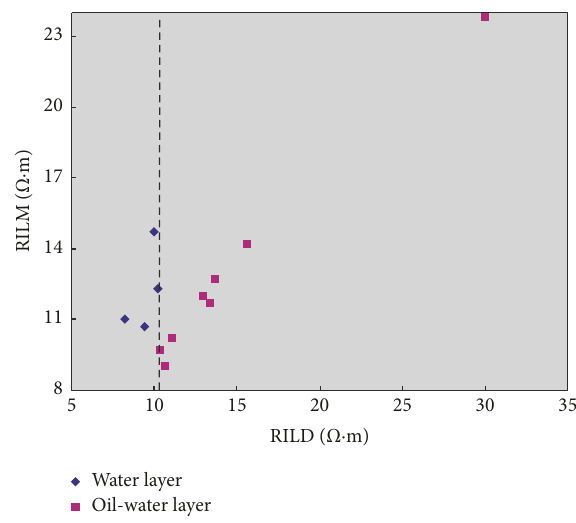
Figure 10: RILD and RILM cross plot at Daqingzijing